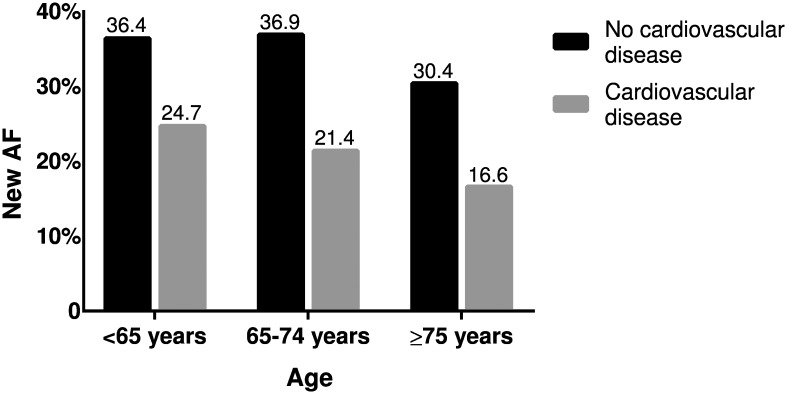
New AF diagnoses at the time of ischemic stroke according to age and cardiovascular diseases.Cardiovascular diseases include coronary artery disease, other vascular diseases, congestive heart failure and hypertension. Cardiovascular disease: N = 2,271 (<65 years: N = 215; 65–74 years: N = 533; ≥75 years: N = 1,523). No cardiovascular disease: N = 643 (<65 years: N = 107; 65–74 years: N = 187; ≥75 years: N = 349). Abbreviations: AF, atrial fibrillation.